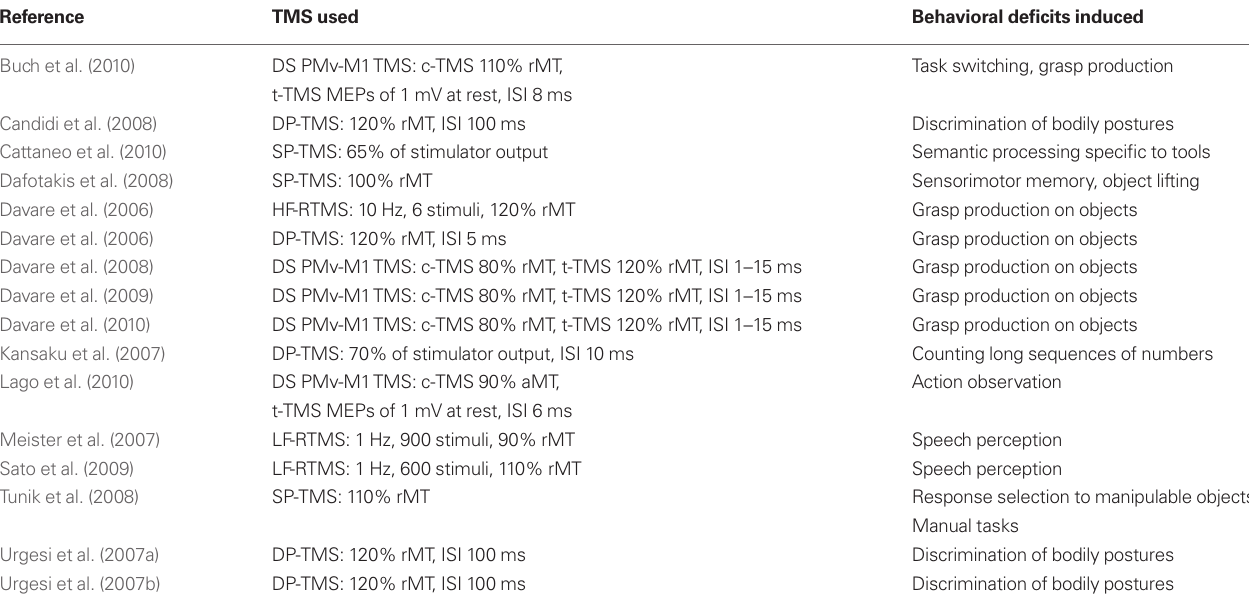
Table 2 | TMS studies of PMv.